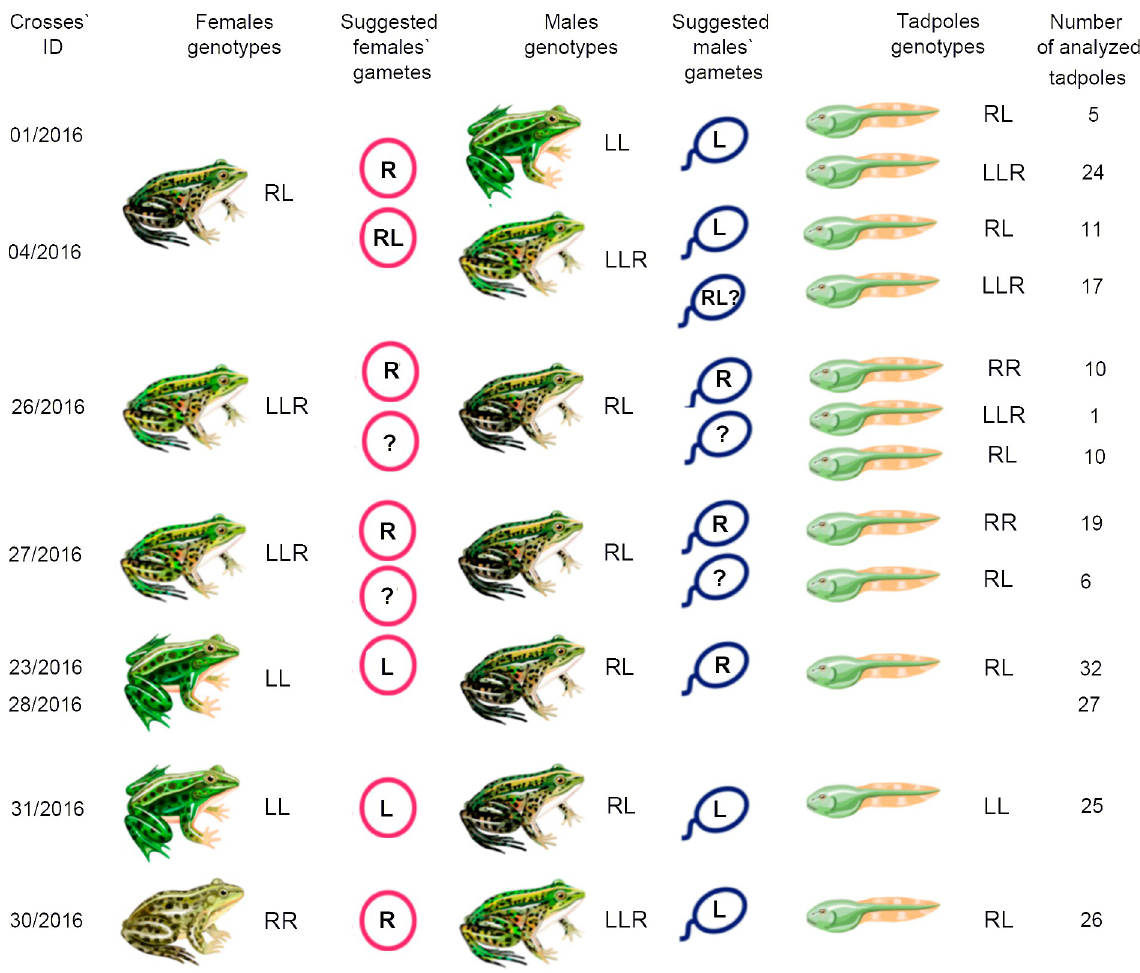
Fig 2. Results of crossing experiments of diploid and triploid hybrids from pure hybrid system located in the northwest (Wysoka Kamie ń ska) Poland. Genome composition of tadpoles was identified by karyotyping followed by FISH. RR indicates P . ridibundus individuals; LL indicates P . lessonae individuals; RL indicates diploid hybrids; LLR and RRL indicate triploid hybrid individuals. Suggested genome composition of eggs and sperm is inferred based on tadpoles’ karyotypes and parents‘genotypes. R and L indicate gametes with P . ridibundus and P . lessonae genomes, respectively. RL indicates diploid gametes with the genomes from both parental species. Question mark (?) shows inability to deduce precise genome composition of gametes produced by hybrid males or females. Crossing IDs correspond to